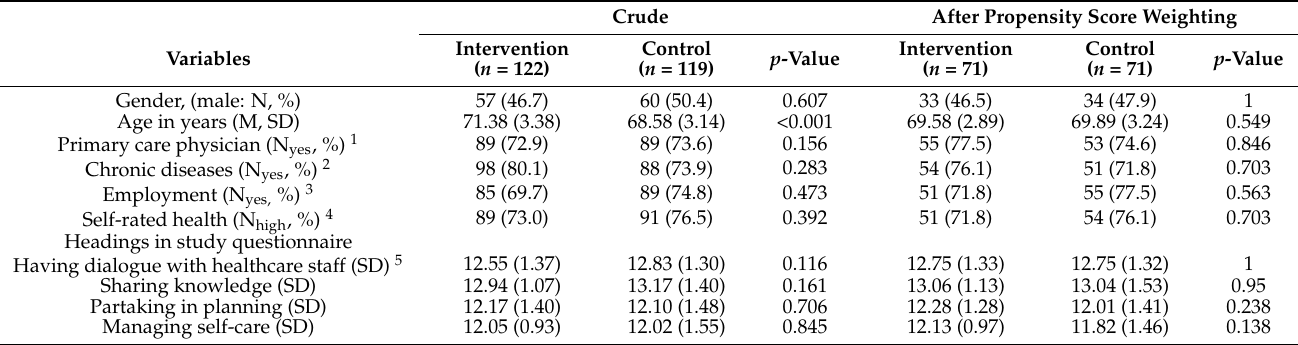
Table 2. Demographic data of participants in each group, and the significance level of the comparison among the two groups before and after propensity score